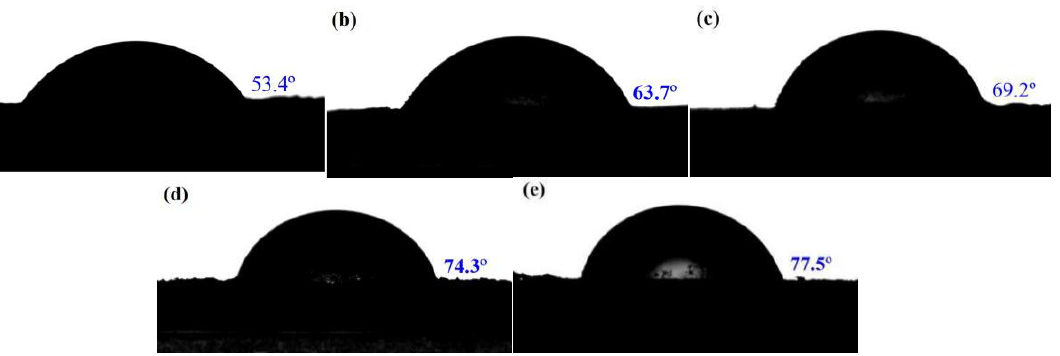
Figure 7. The static contact angles of ( a ) CL-20/HMX cocrystal; ( b ) CH@MF-2; ( c ) CH@MF-3; ( d )